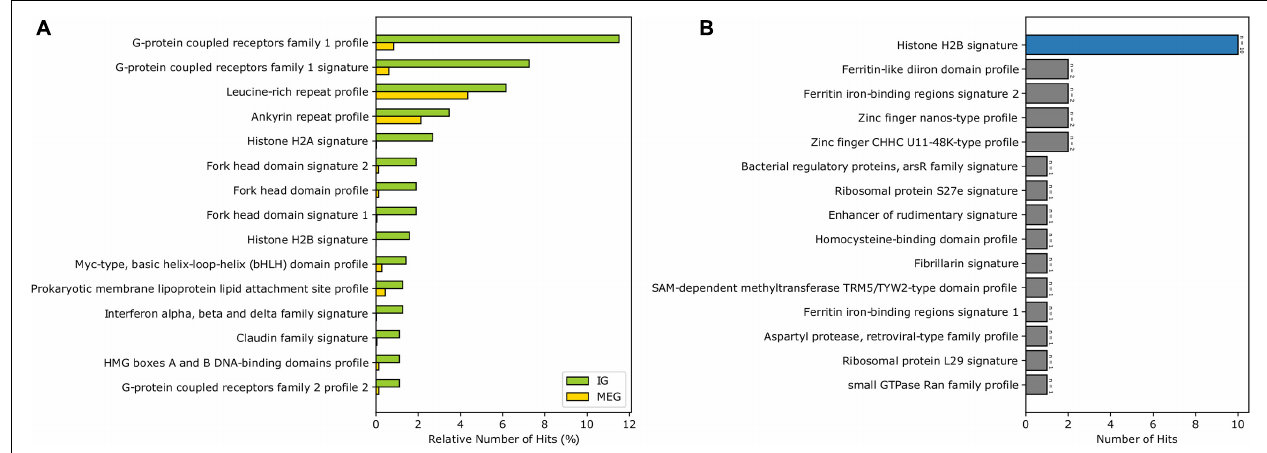
FIGURE 3 | Enrichment of the PROSITE signatures in mouse IG proteins compared to MEG proteins. (A) The 15 most abundant PROSITE signatures of IG proteins. (B) PROSITE signatures exclusive of IG proteins (signatures belonging to the Histones class are shown in blue).